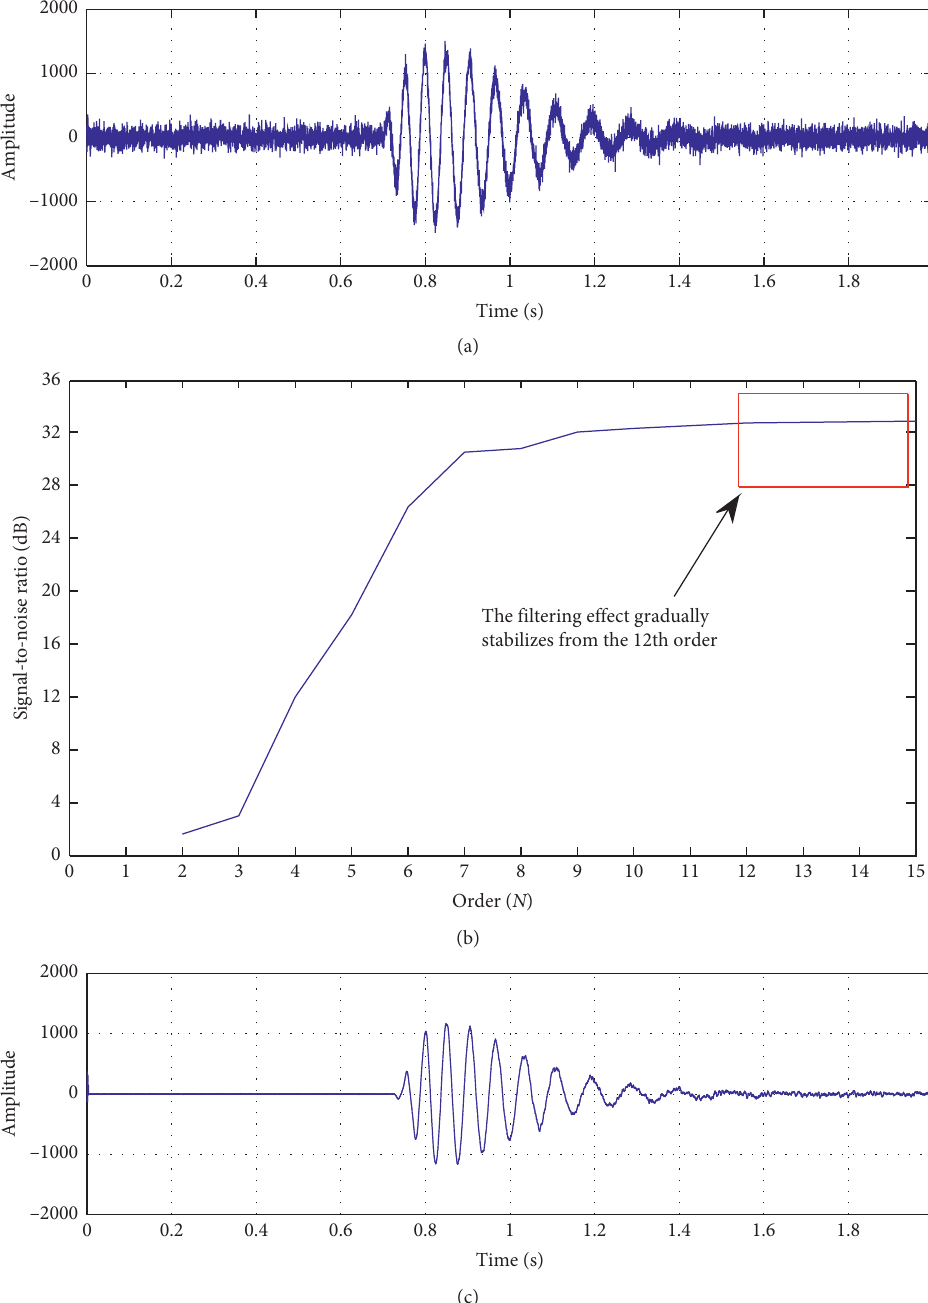
Figure 6: Simulation validation diagram of filter orders. (a) Simulation signal diagram of 0dB noise explosion seismic wavelet. (b) Simulation results of SNR after filtering with different orders. (c) Simulation result graph of a filter with an order N �